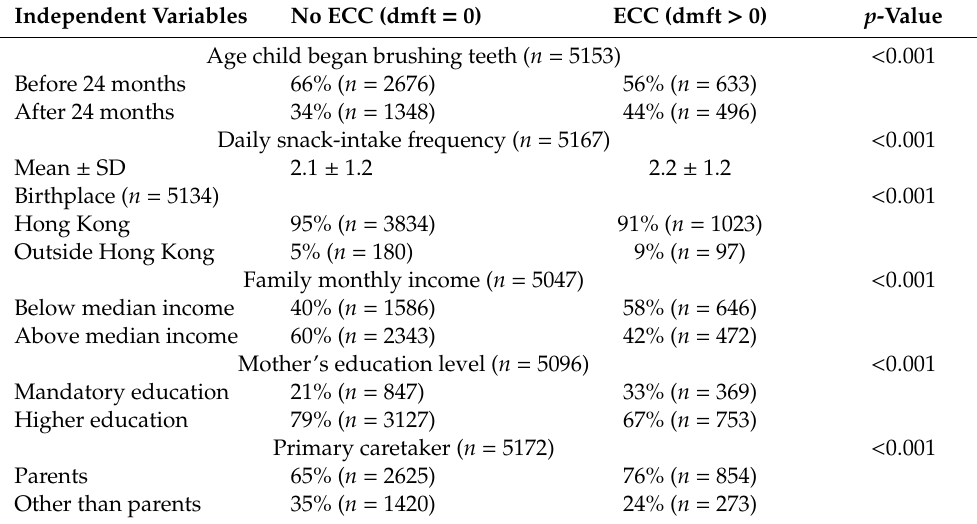
Table 2. ECC in Hong Kong children and associated factors (adapted from Gao et al., 2018 [16]). Independent